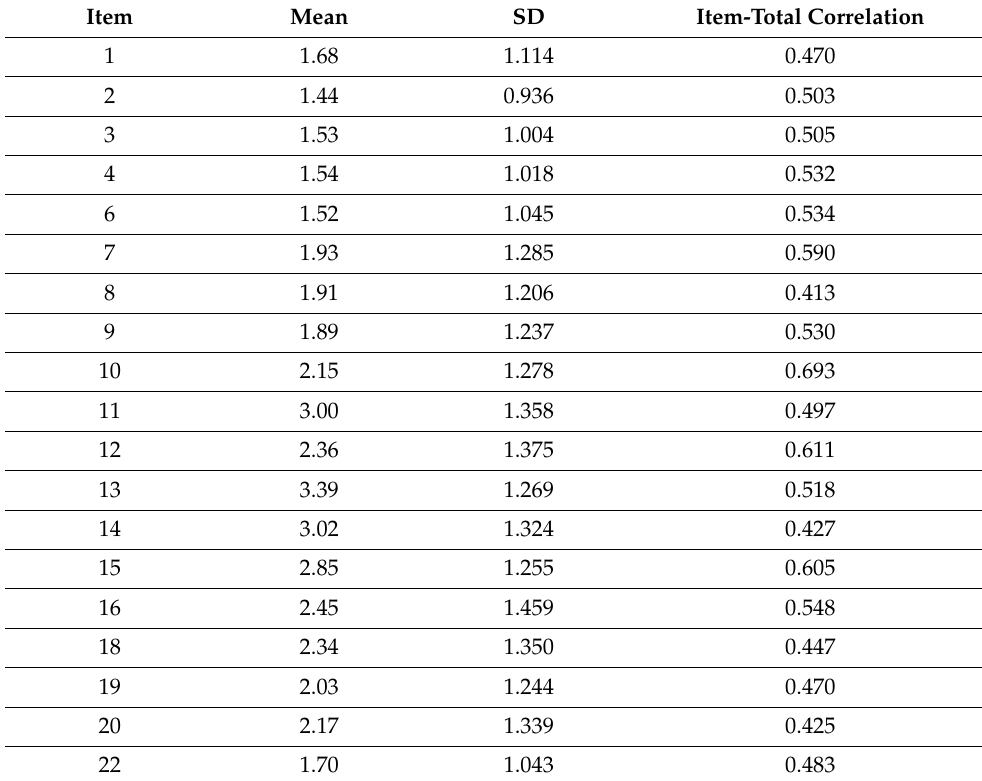
Table 4. Mean, standard deviation, and item–total correlation for the items of the